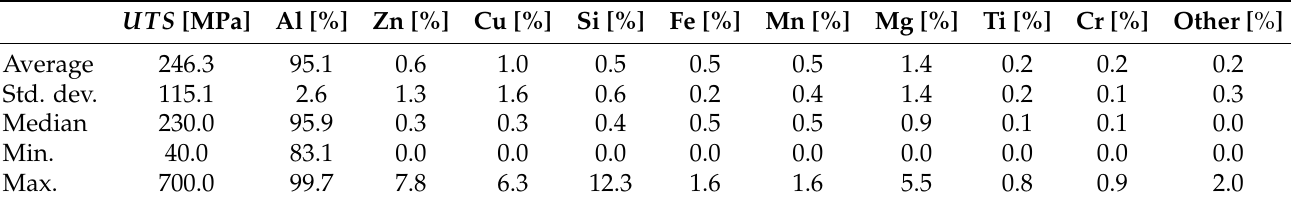
Table 1. Statistical information about the input dataset.